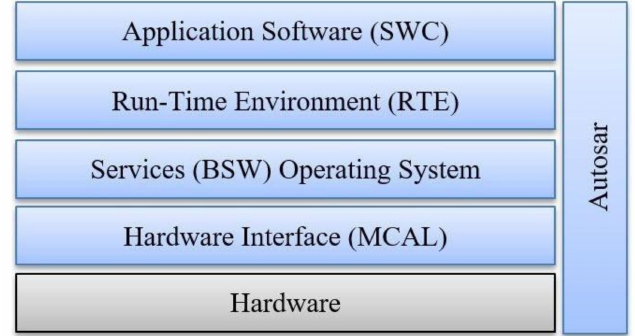
Figure 1. AUTOSAR